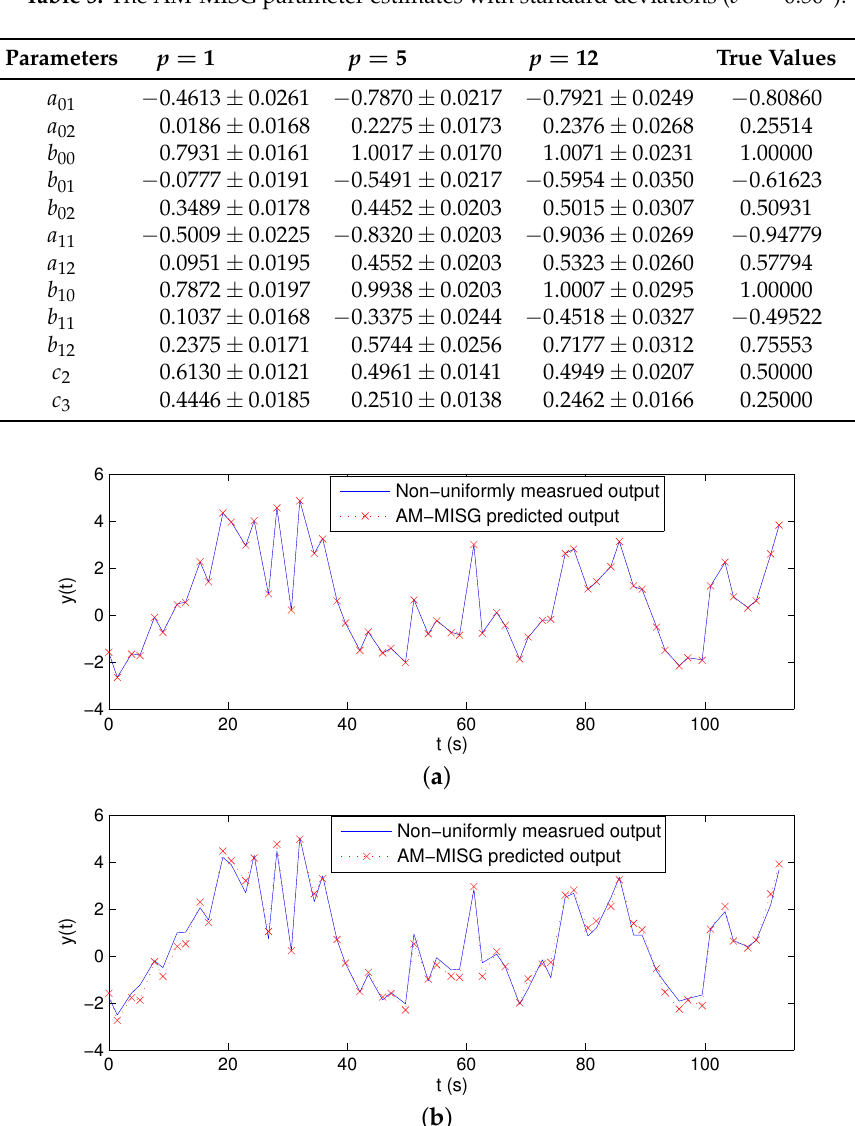
Figure 4. The predicted outputs and the measured outputs. ( a ) For the noise variance σ 2 = 0.10 2 . ( b ) For the noise variance σ 2 = 0.50 2